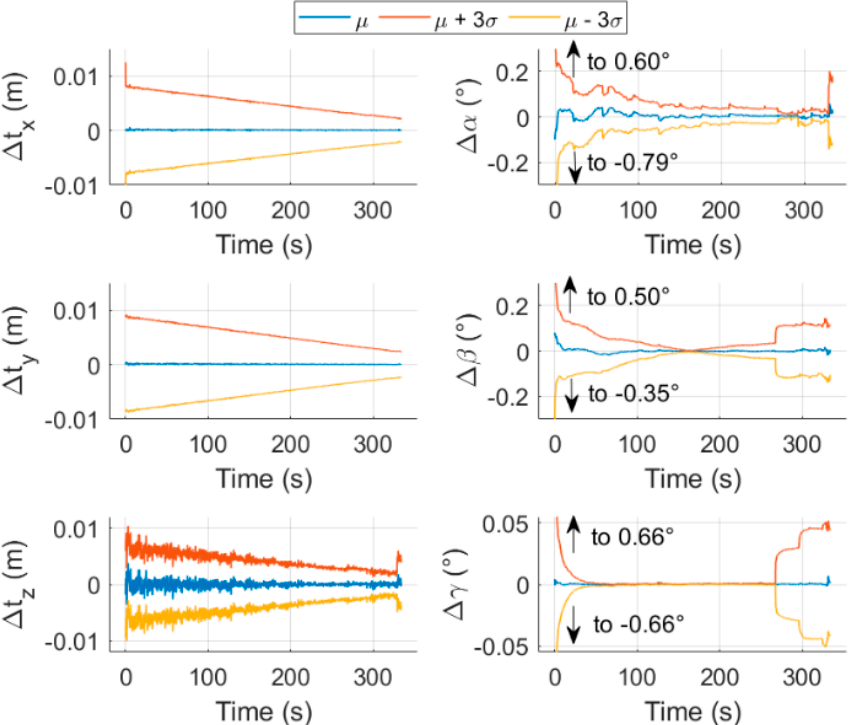
Figure 13. Temporal evolution of the mean of the errors on the pose parameters, with representation of the 3 σ intervals, for test case S1. The plots are focused on intervals about the mean values: the arrows indicate the maximum values reached by the pose initial guess at scenario start.